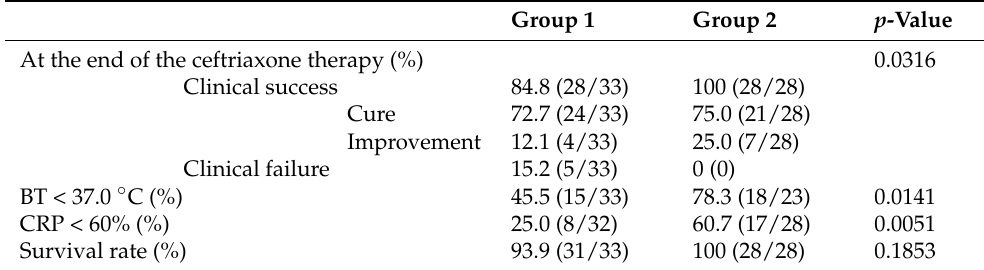
Table 2. Clinical effectiveness of registered